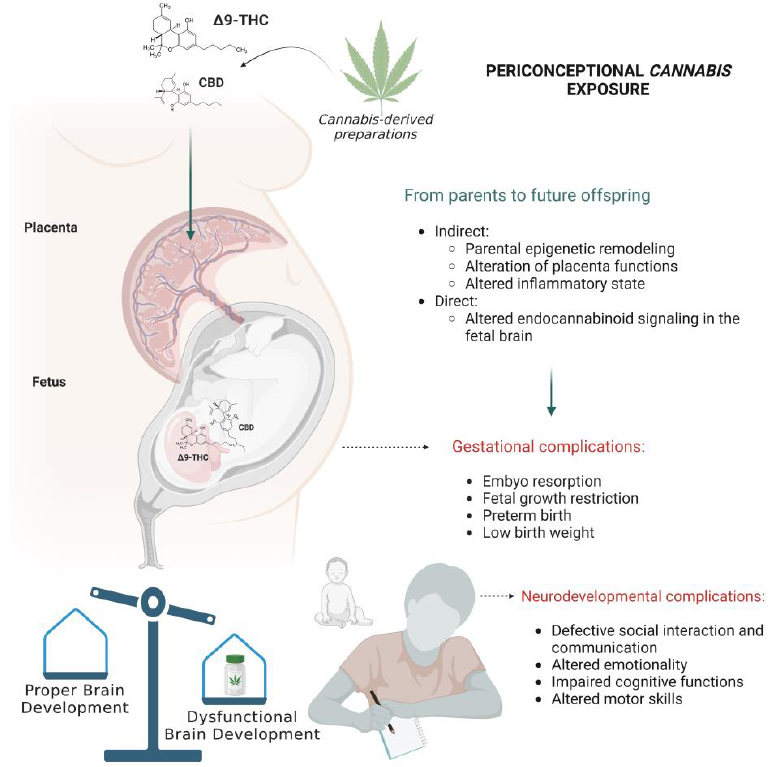
Figure 2. Prenatal Cannabis exposure can affect gestational processes and neurodevelopmental trajectories in the offspring through both direct and indirect mechanisms. Figure created with “https://www.biorender.com/ (accessed on 8 March 2023)” .